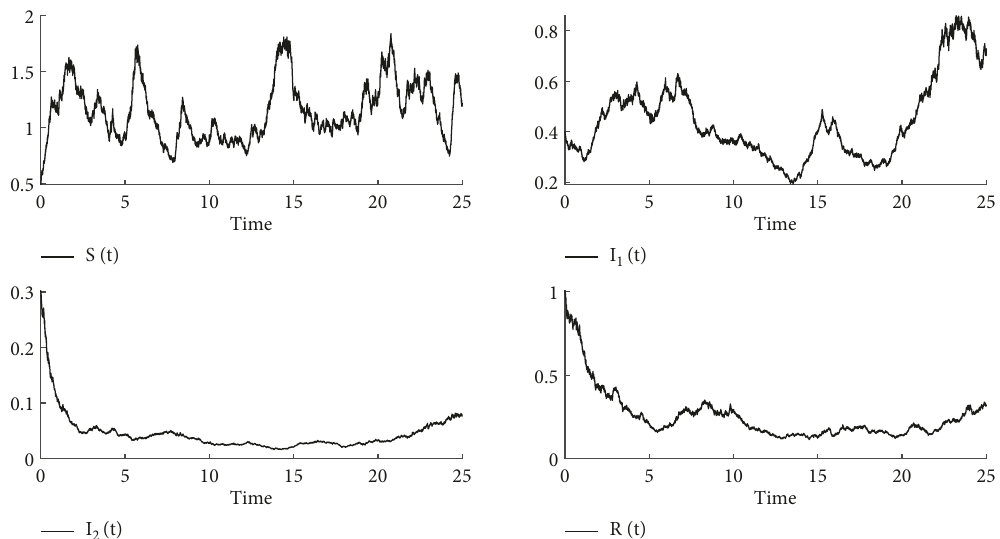
Figure 2: Numerical simulations of the path S ( t ) , I